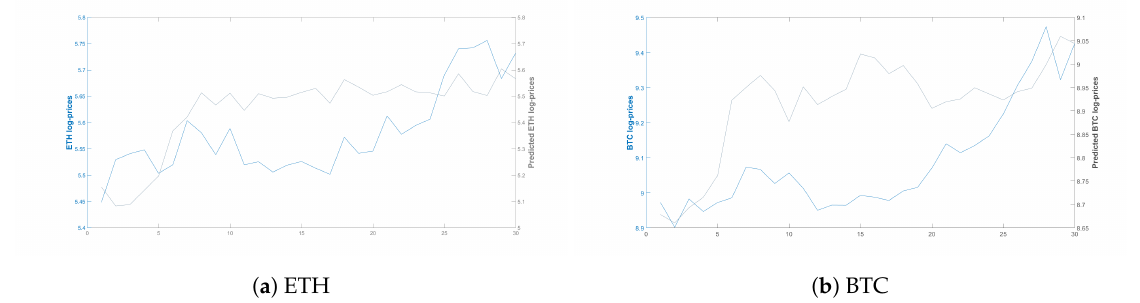
Figure 4. Mean posterior out-of-sample predictions (gray line) for L = 30 days both for the ( a ) ETH and ( b ) BTC log-transformed price series (blue line). While the predictions for ETH are better than those for BTC, both are not satisfactory as they frequently miss the direction of price movement. The BTC predictions are essentially the same for both the 2016–2019 and 2013–2019 data sets (the second not shown